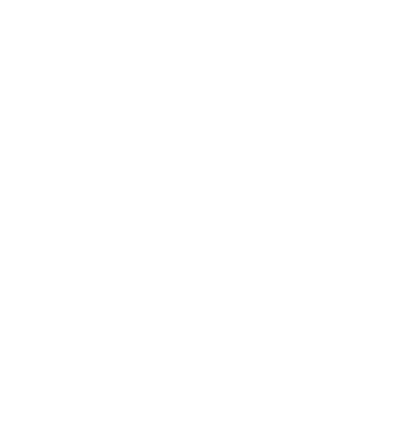
Figure 14. Strain trend in the bottom section of the wing undergoing twist with respect to deflection due to morphing.